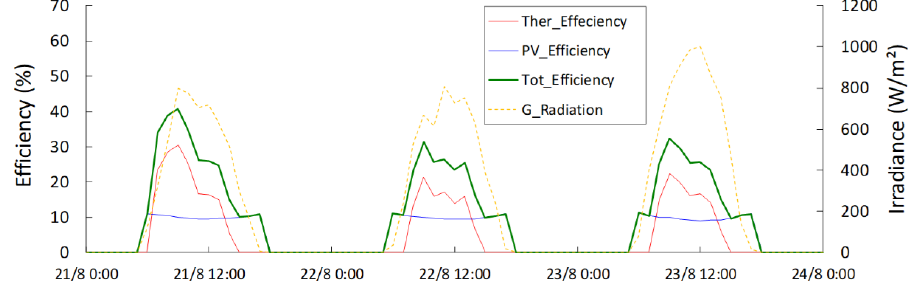
Figure 9. Thermal, electrical, and total efficiencies of the PVT system in Koua during three typical summer days.